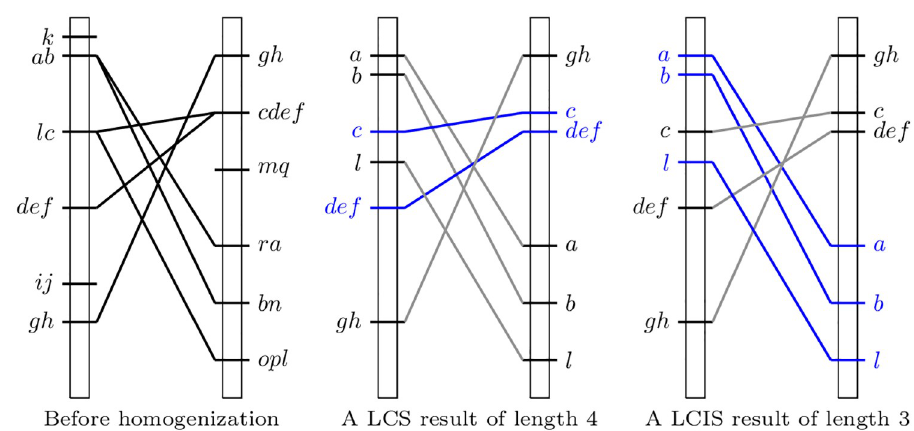
Fig 2. Comparison of two genetic maps before (left) and after (middle and right) homogenization. The blue elements of the scheme in the middle proposes a consensus without conflict corresponding to an LCS, while on the right they show a consensus without conflict corresponding to the LCIS of π 1 = ({ k }, { a , b }, { l , c }, { d , e , f }, { i , j }, { g , h }) and π 2 = ({ g , h }, { c , d , e , f }, { m , q }, { r , a }, { b , n }, { o , p , l